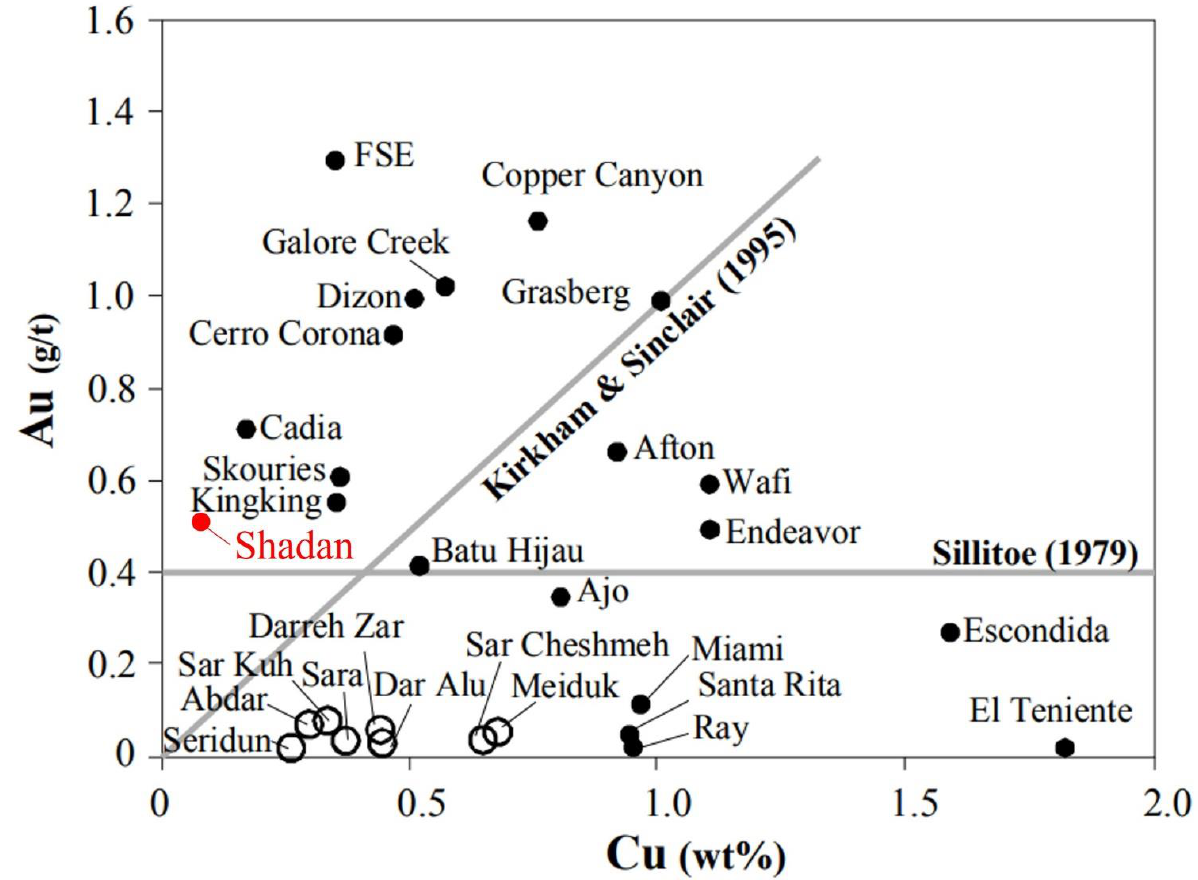
Figure 3. Location of the Shadan porphyry (red circle) compared with Kerman porphyry copper deposits (open circles) [45] on Cu vs. Au diagram on which the porphyry Cu–Au deposits are plotted above the diagonal line of [46] and the horizontal line of [47].